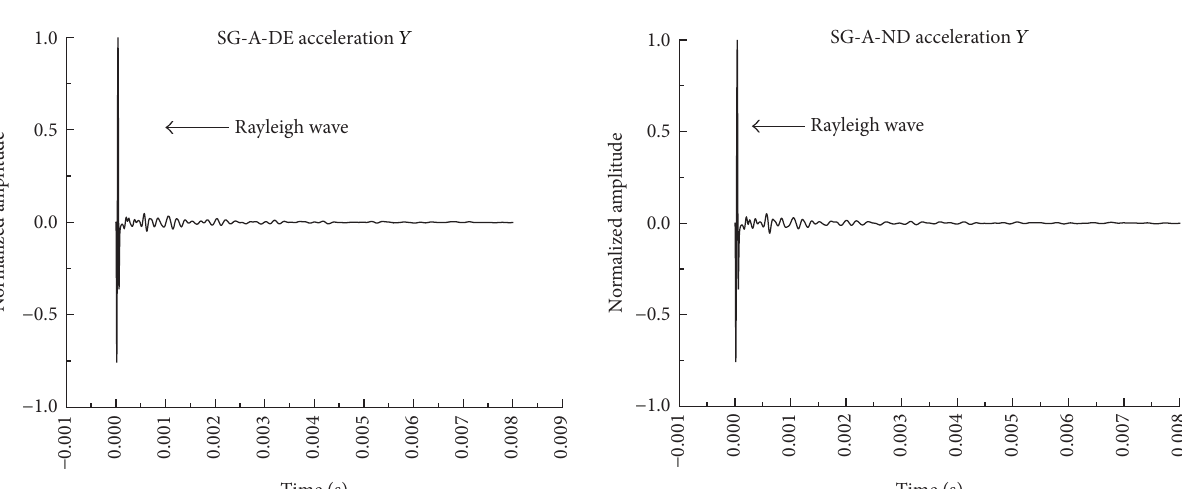
Figure 8: Simulation parameters of exciting force.